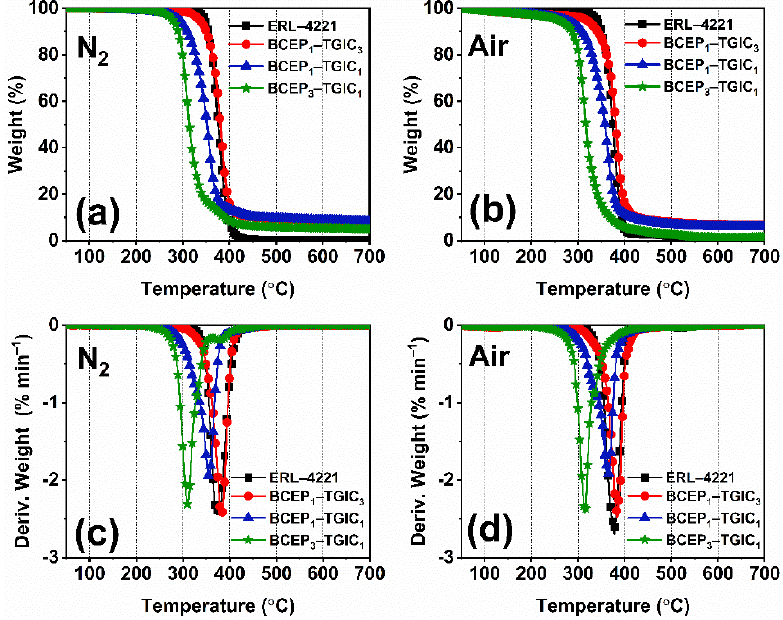
Figure 4. TG ( a , b ) and DTG ( c , d ) curves of the cured resin under nitrogen ( a , c ) and air ( b , d ) atmospheres. Table 4. TG data of the cured resins and their T g acquired from DSC and